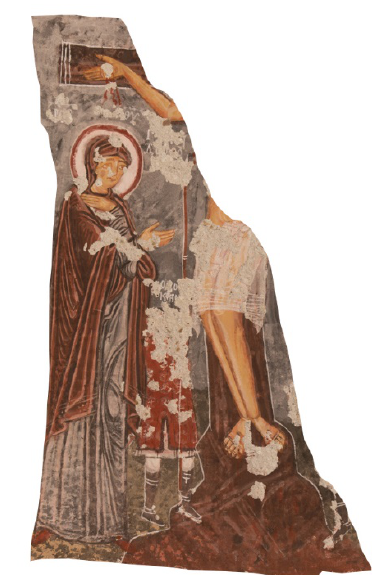
Figure 9. The Virtual toning applied icon of St. Mary in Sarnıç Kilisesi in order to transfer into the Crucifixion of Merymana Kilisesi.